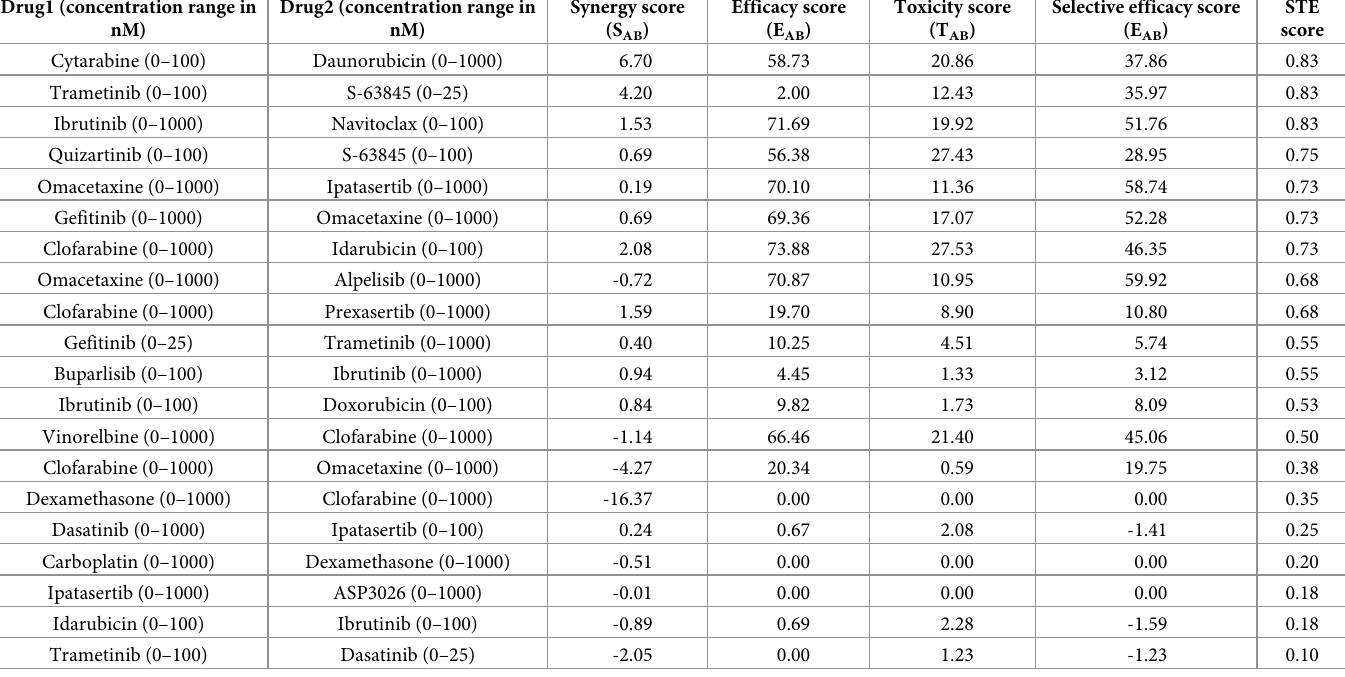
Table 1. Ranking of 20 in-house measured combinations based on STE scores calculated from the most synergistic area of dose-response matrix in T-PLL and healthy control cells. Drug1 (concentration range in Drug2 (concentration range in Synergy score nM) nM) (S AB